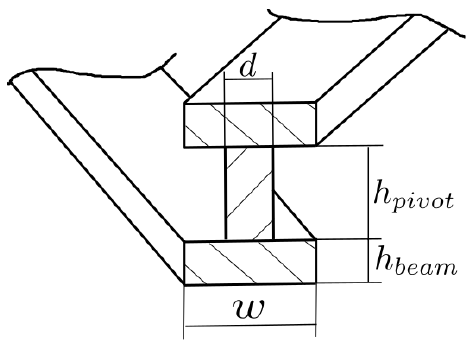
Figure 3. Schematic cross-section of a periodic cell of a pantographic structure.